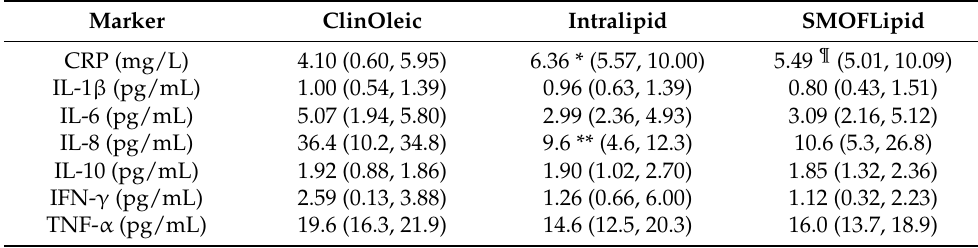
Table 7. Plasma inflammatory markers in patients receiving different lipid emulsions. Data are median (interquartile